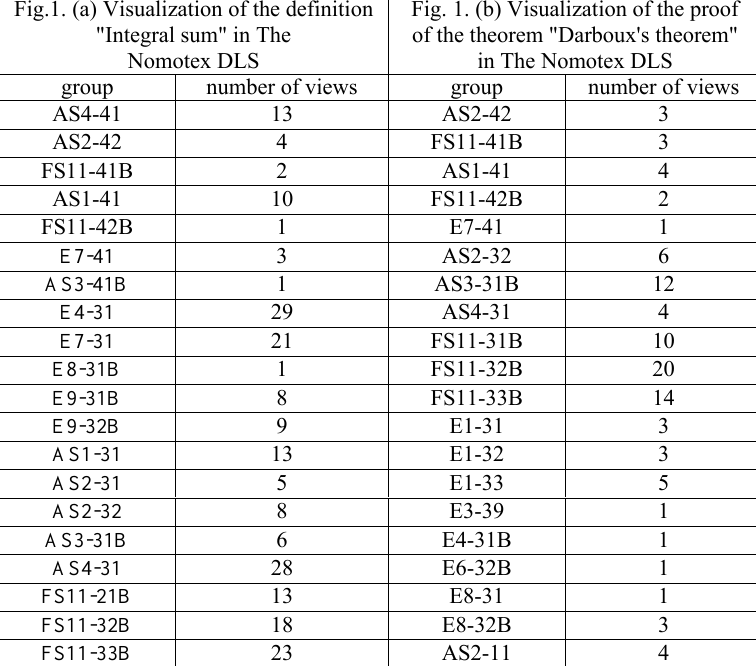
Fig.1. (a) Visualization of the definition Fig. 1. (b) Visualization of the